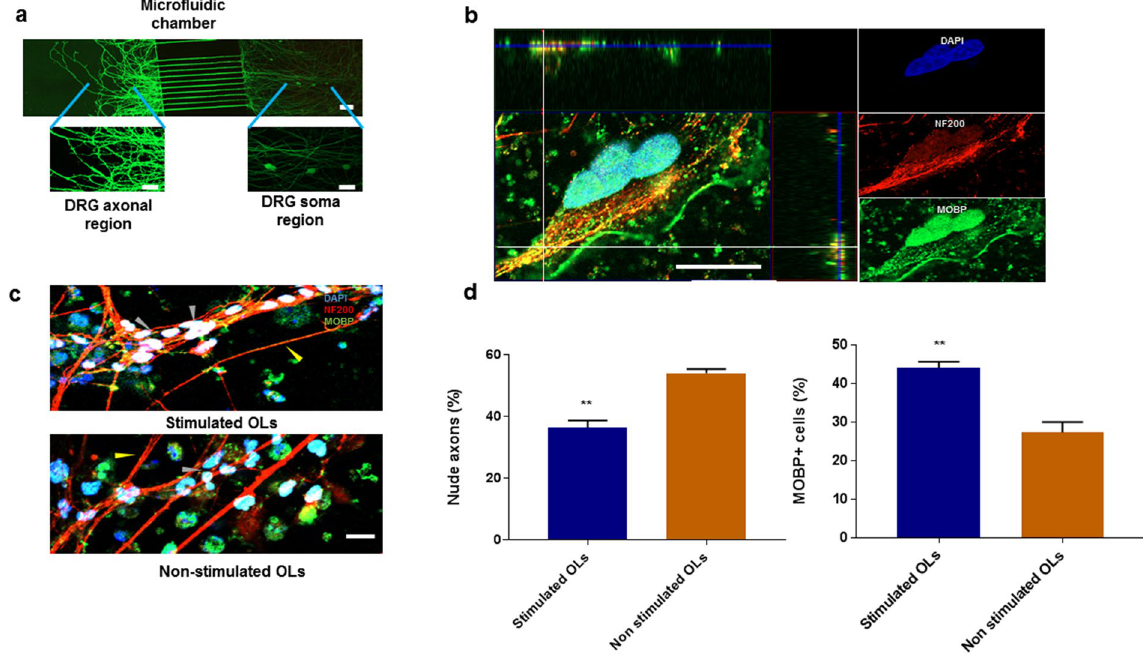
Figure 6. Investigation of myelination potential of SMF stimulated OPCs in DRG microfluidic chamber. ( a ) Illustration of microfluidic chamber with axonal and soma compartments connected with 10 μ m wide and 500 μ m long microchannels. DRG neurons (stained with Calcein) were plated in the somatic chamber and only axons (no cell body) extends to the axonal chamber. ( b ) Representative image demonstrating the wrapping of axons stained with Neurofilament-200 by MOBP + oligodendrocytes. 3-D analysis of the z-stack images indicate co-localisation of myelinating cells (green) with axons (red) in the z-domain, ( c ) Representative image demonstrating an increase in myelinating cells (grey arrow) and decrease in nude axons (yellow arrow) in chambers containing SMF stimulated oligodendrocytes as compared to non-stimulated oligodendrocytes. The control OL chamber has fewer cells making contact with the axons. ( d ) Quantification of number of MOBP + oligodendrocytes and nude axons. Scale bar = 20 µ m, ( ** p <